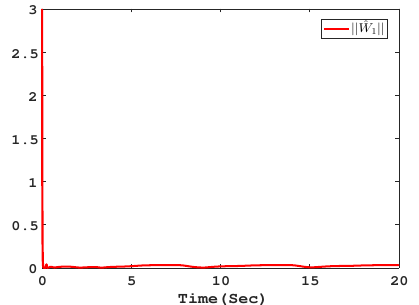
Figure 5. The trajectory of the norm for the NN weight ˆ W 1 .